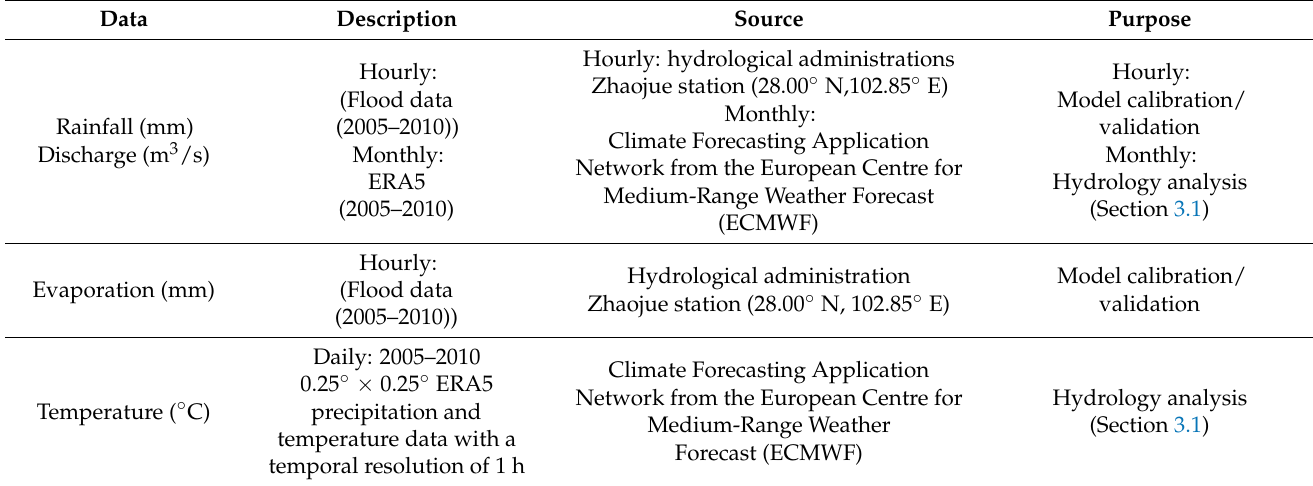
Table 1. Details of various types of data used for developing the coupled